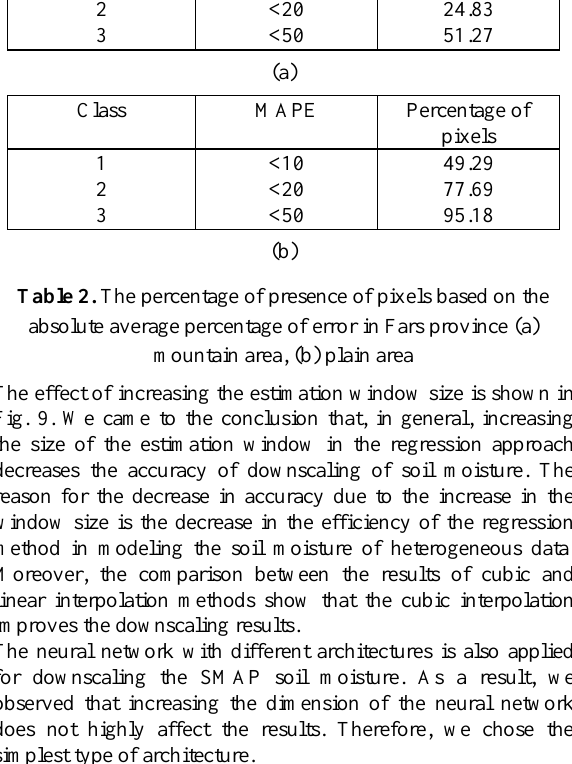
Figure 8 . Diagram of regression method in Fars province (a) mountain area, (b) plain area. Figure 6 . Mean absolute percent error (MAPE) histogram of the regression method in Fars province (a) mountain area, (b) plain area.